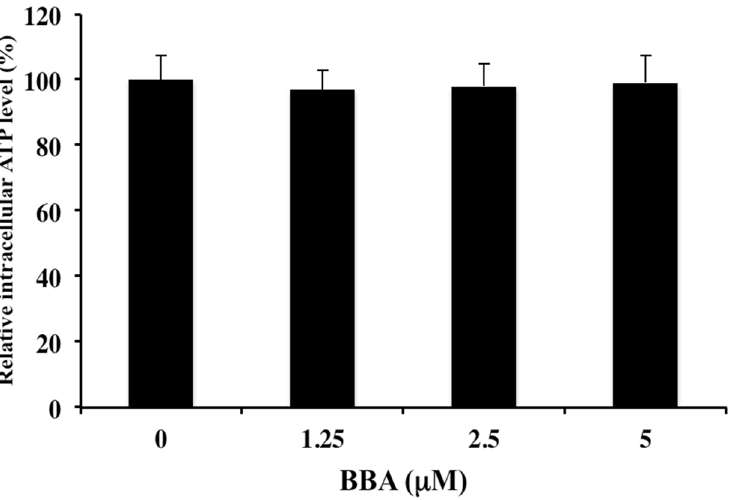
Figure 6. Immunoblotting of ABCB1/P-gp (A) and MRP7 (B) in HEK293 and HEK293/MRP7 cells and Immunofluorescence detection of MRP7 in HEK293/MRP7 cells (C). Cell lysates were prepared from HEK293/pcDNA3.1, HEK293/ABCB1 and HEK293/MRP7 cells (A), HEK293/MRP7 cells incubated with 5 µM BBA for different time periods (0, 24, 48 and 72 h) (B). Equal amounts (40 µg of protein) of total cell lysates were used for each sample. The localization of MRP7 by immunofluorescence was done on paraformaldehyde fixed cells using polyclonal antibody D19 against MRP7 and Alexa Flour ® 488 donkey anti-goat IgG(C). DAPI was used for nuclear counterstaining. Results from a representative experiment are shown. Similar results were obtained in two other trials. doi: